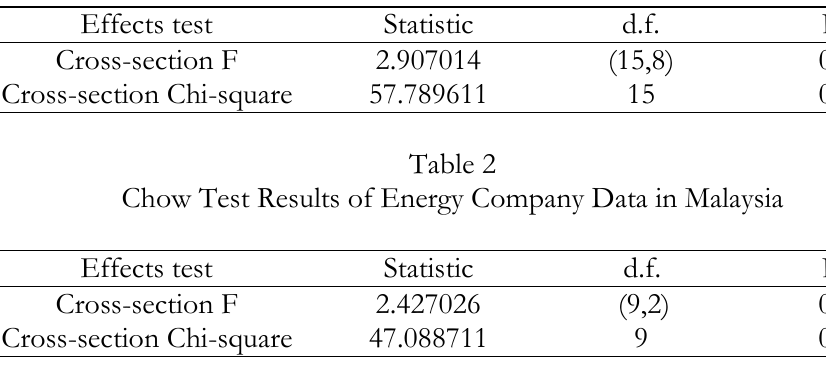
Chow Test Results of Energy Company Data in Indonesia